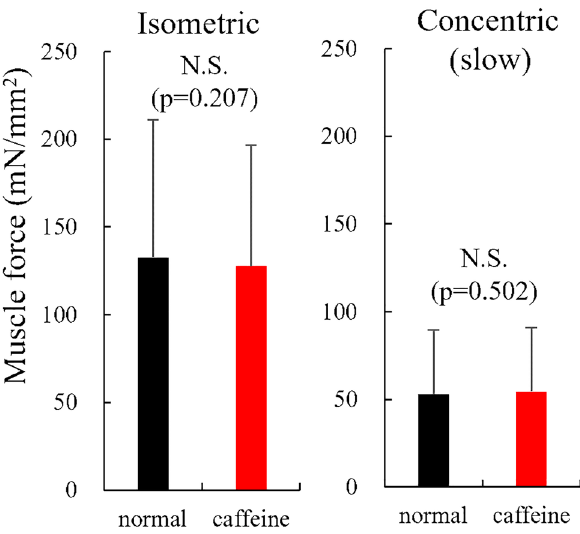
Figure 4. Muscle force obtained during the isometric and concentric phases in the slow shortening trials between normal and caffeine conditions (N = 10) (values are means ±